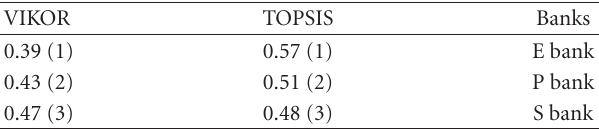
Table 8: Summary of final preference order ranking by VIKOR and